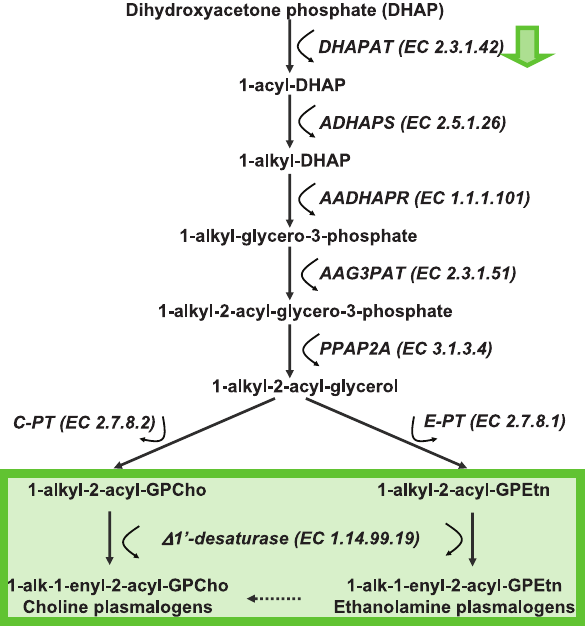
Figure 3. Schematic representation of the steps involved in the biosynthesis of ether phospholipids, including plasmalogens. The lipids found consistently downregulated in serum of children who later developed type 1 diabetes [3] are shown in green box. DHAPAT enzyme is found in the downregulated paths in early insulitis in the present study (green arrow). The first three reactions in the pathway take place in peroxisomes, whiletheothers arecatalyzedbymicrosomalenzymesystems. Other routes for the formation of ether phospholipids may exist [16].